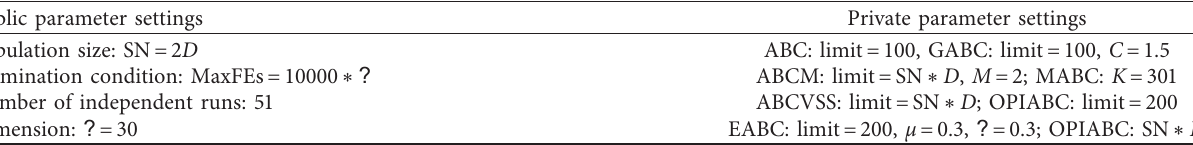
Table 1: The parameter settings of eight compared ABCs.